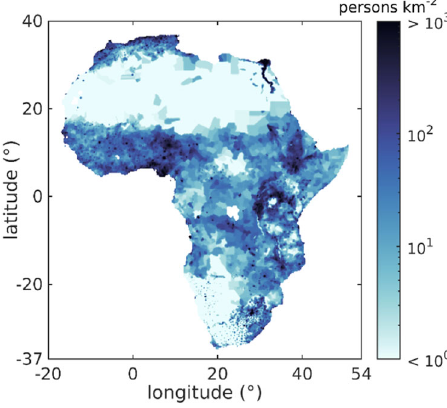
Fig. 8 Population density. The results are plotted in a blue scale. Data from ref. 39